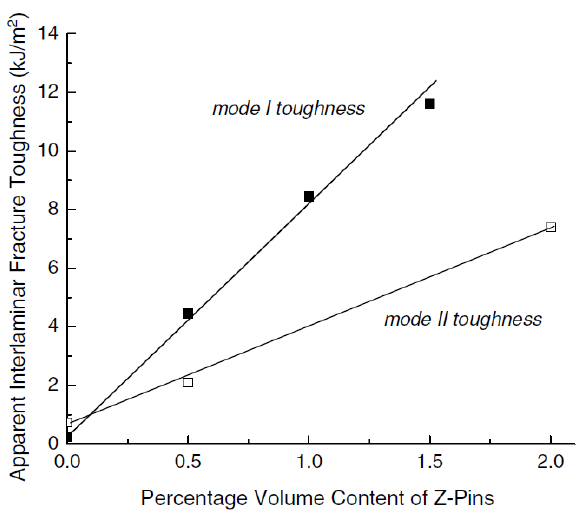
F igure 52. Effect of z-Pins volume content on the apparent mode I and II interlaminar fracture toughness [1].